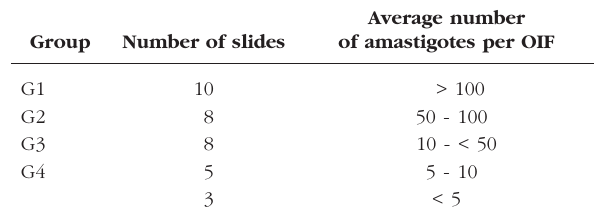
Table I. – Quantitative grading of Leishmania amastigotes using stained slides and light microscopy.